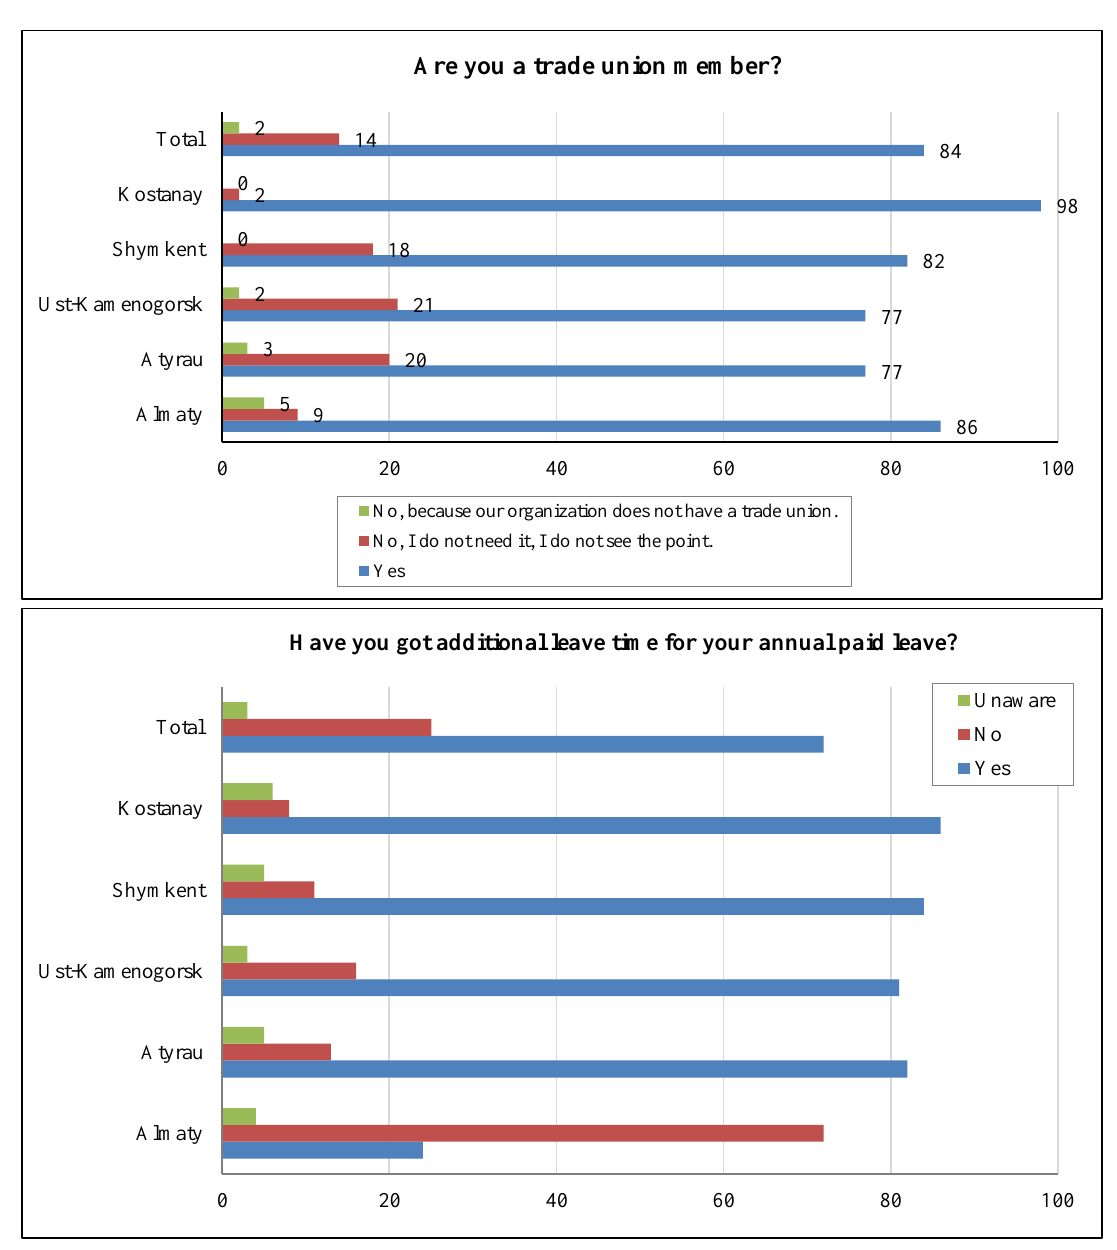
Figure 6. Data on the employees' trade union membership and other